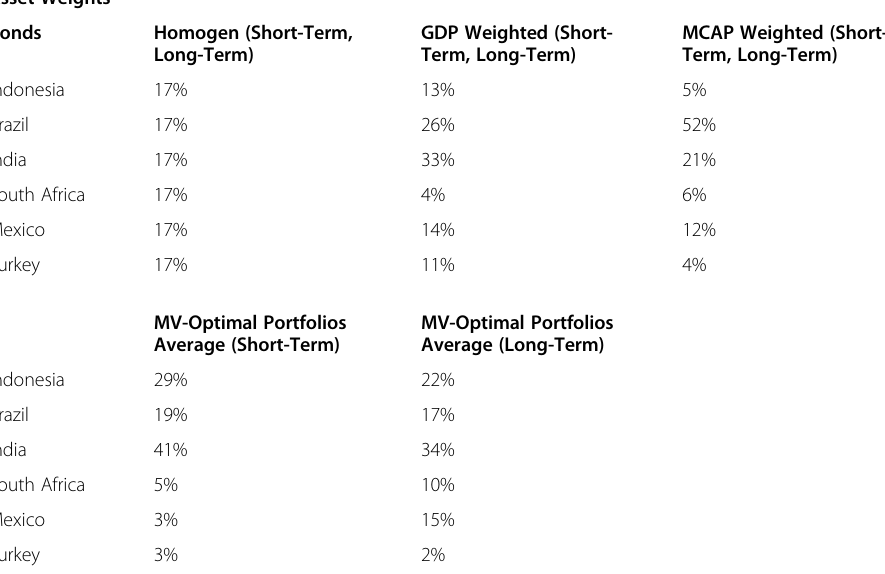
Table 7 Sample portfolios Asset Weights